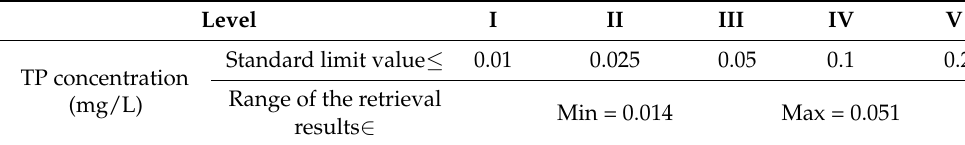
Table 3. The standard limit value of the TP concentration in